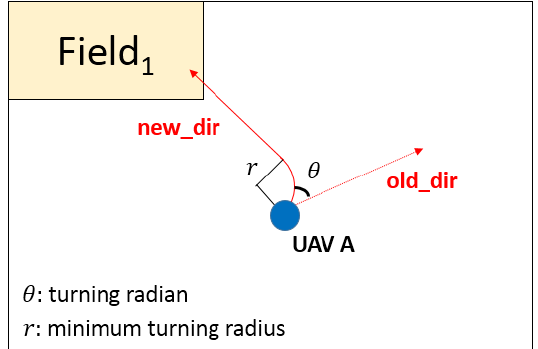
Figure 13. The process of adjusting the heading direction.